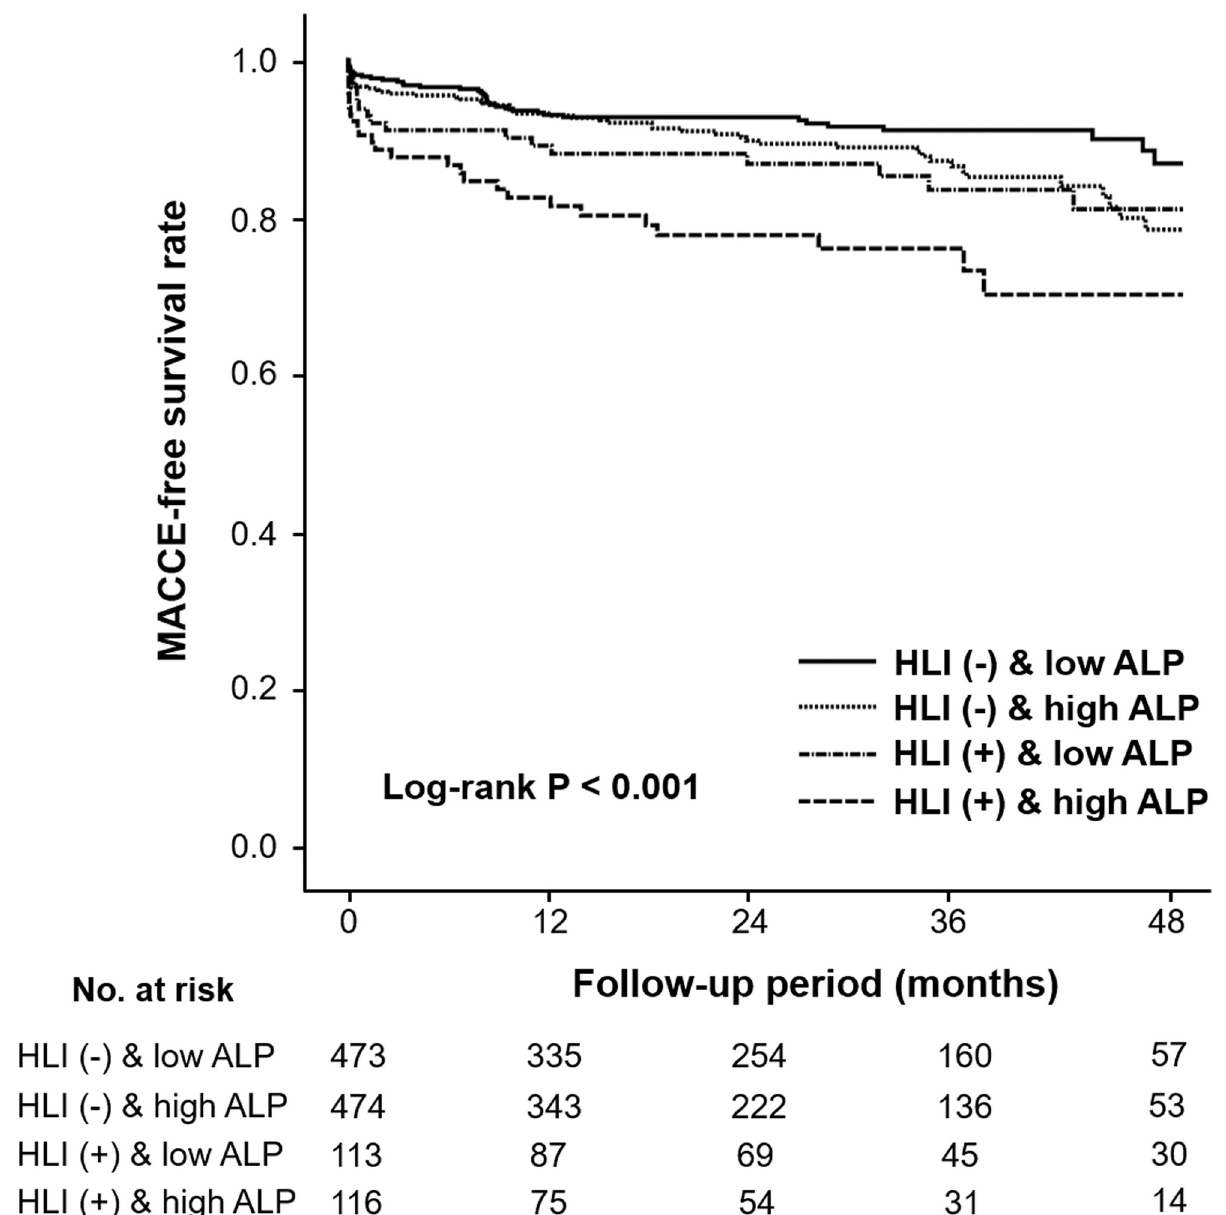
Fig 1. Major adverse cardiac or cerebrovascular event (MACCE)-free survival curve according to risk groups defined by combination of hypoxic liver injury and serum alkaline phosphatase (ALP) level.